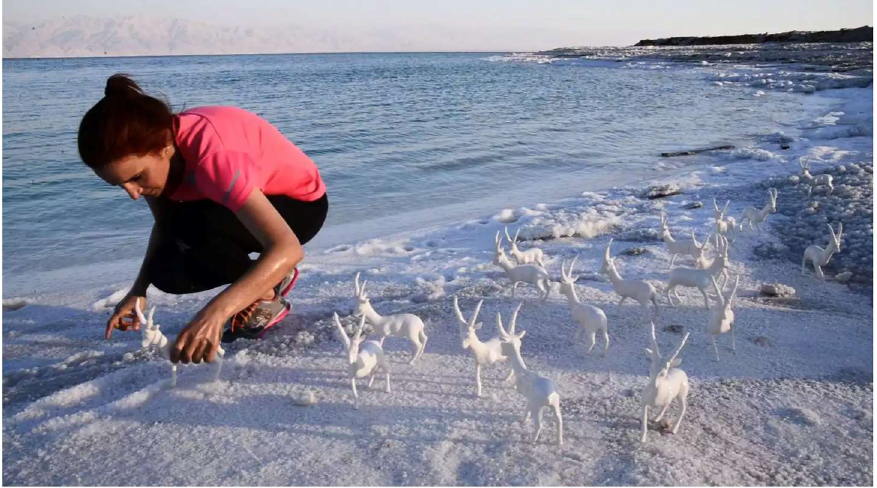
Figure 7. Manal Mahamid, Fine Dust , 2017, Video art on loop, 08:02 min.